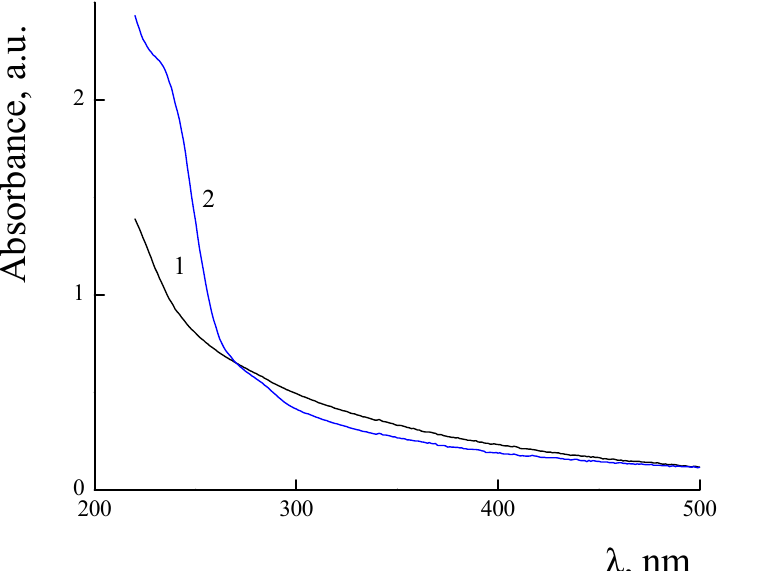
Figure 9. Absorbance spectra of PLAMs–us (1) and PLAMs–PTX (2). Concentration of micelles 0.5 mg/mL, Tris buffer with pH 7, c = 0.01 M, 25 °C.